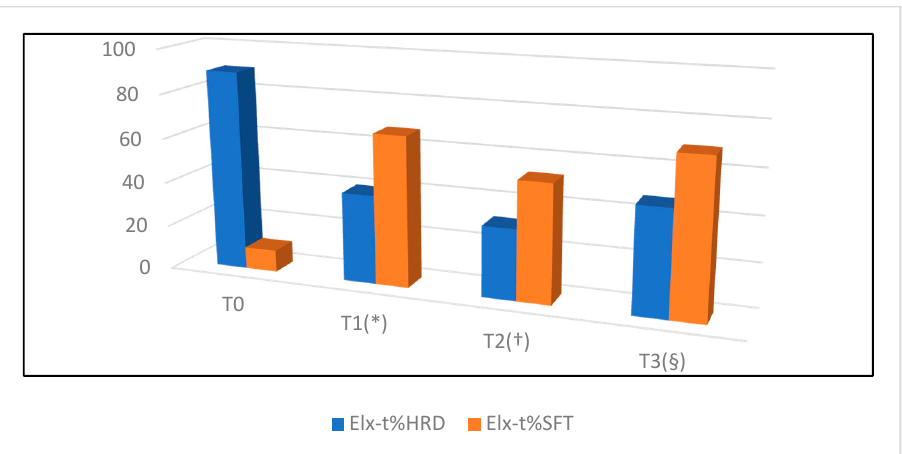
Figure 7. Graphic representation of progression of tendon healing expressed in percentage of hard and soft tissue, assessed by elastosonography. Statistical difference ( p < 0.05) between: T 0 –T 1 (*), T 0 –T 2 ( † ), T 0 –T 3 ( § ).